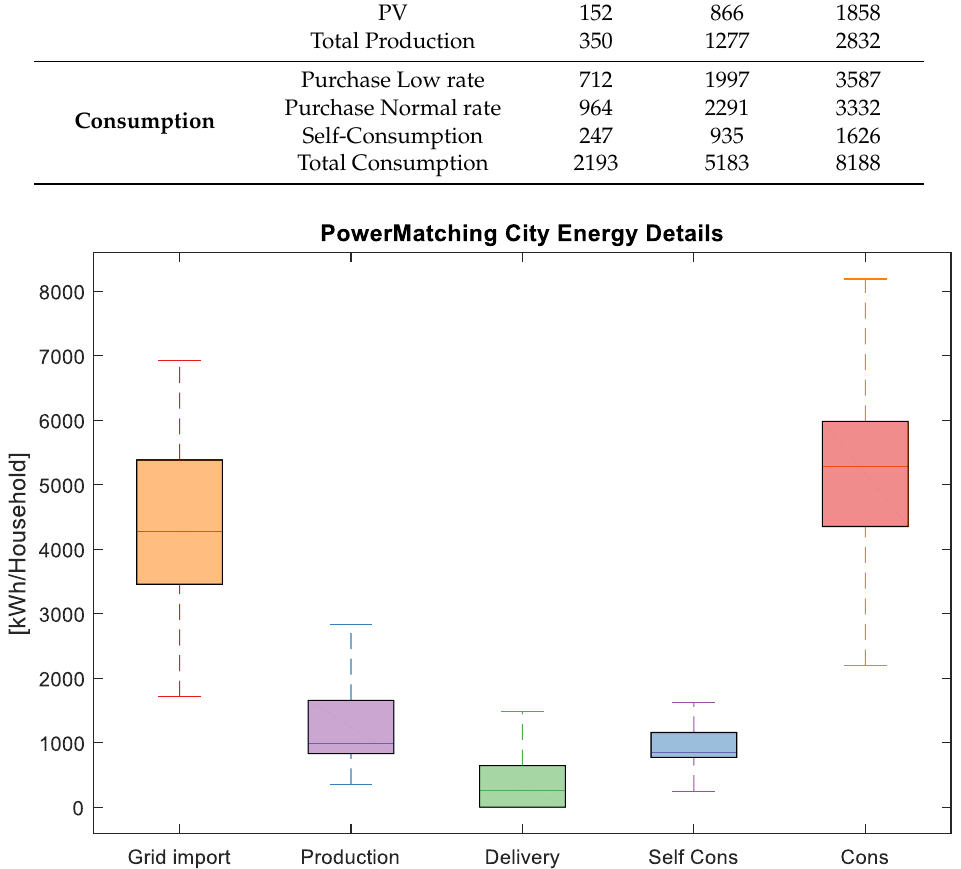
Figure 3. PowerMatching City electricity summary for the year 2012 per household.